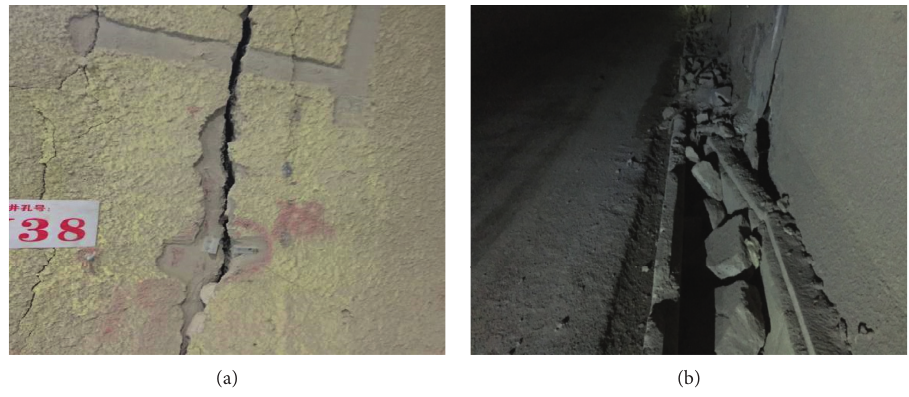
Figure 10: Tunnel diseases in November 2013. (a) Lining cracking. (b) Movement of cable duct. Table 1: Information of the two typical damaged tunnel sections. Typical sections